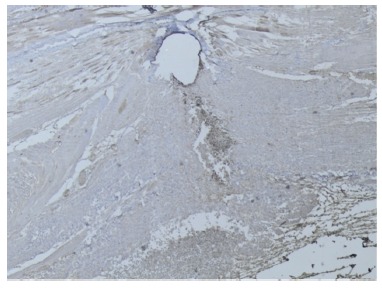
VEGF, group A, 40x,++